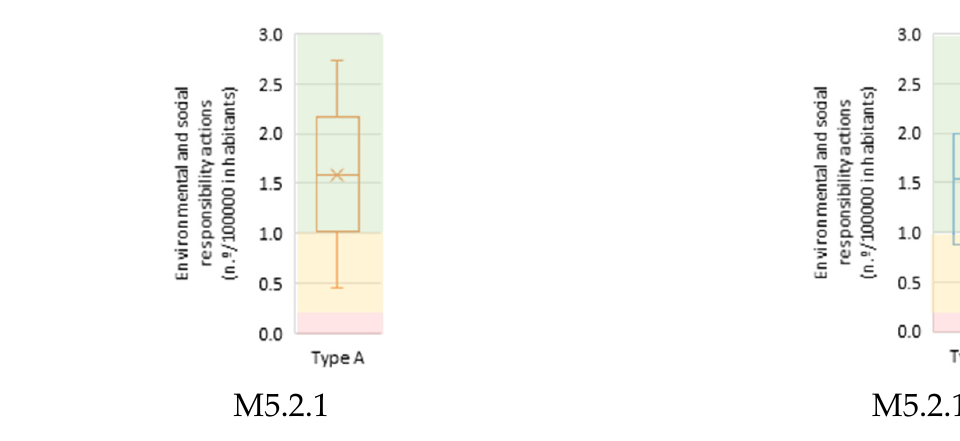
Figure 9. Results of the validation applied to the wastewater utilities: objective 5.